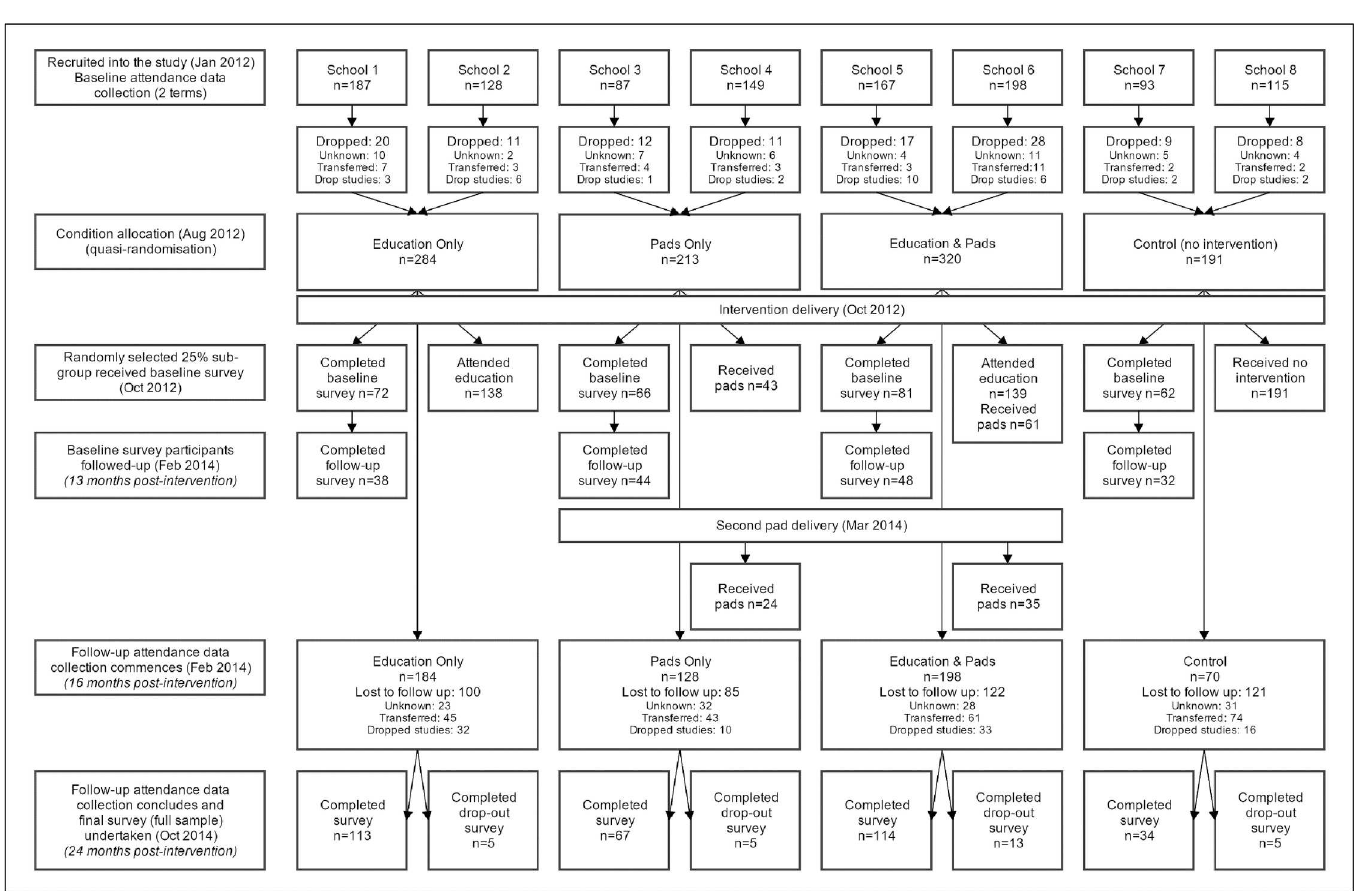
Fig 1. Participant flow